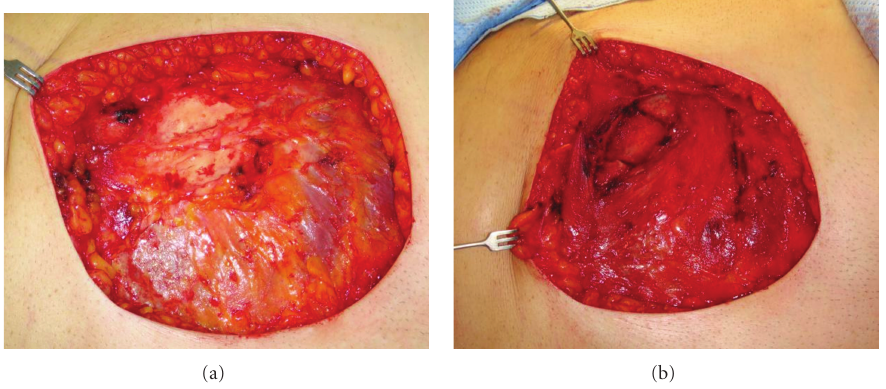
Figure 3: (a) Necrotic muscle covering the rib after the removal of radiodermatitis. (b) Situs after partial removal of the 4th rib.